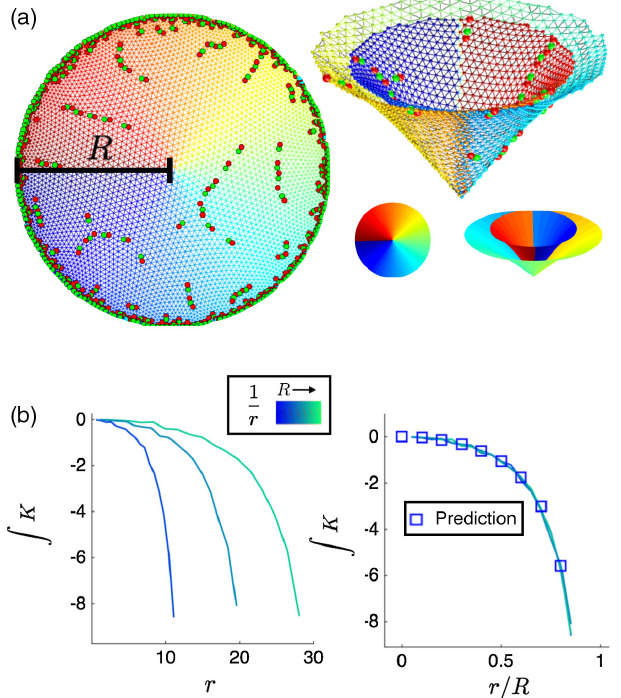
FIG. 4. Simulated hard-wall confined crystal with a corre- sponding negatively curved surface. (a) Circular wall boundary.